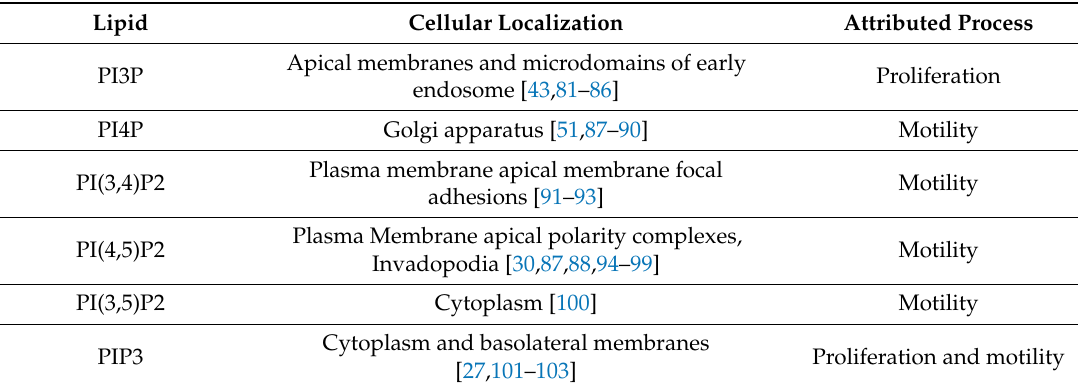
Table 8. Overview of PI lipids and associated tumorigenic